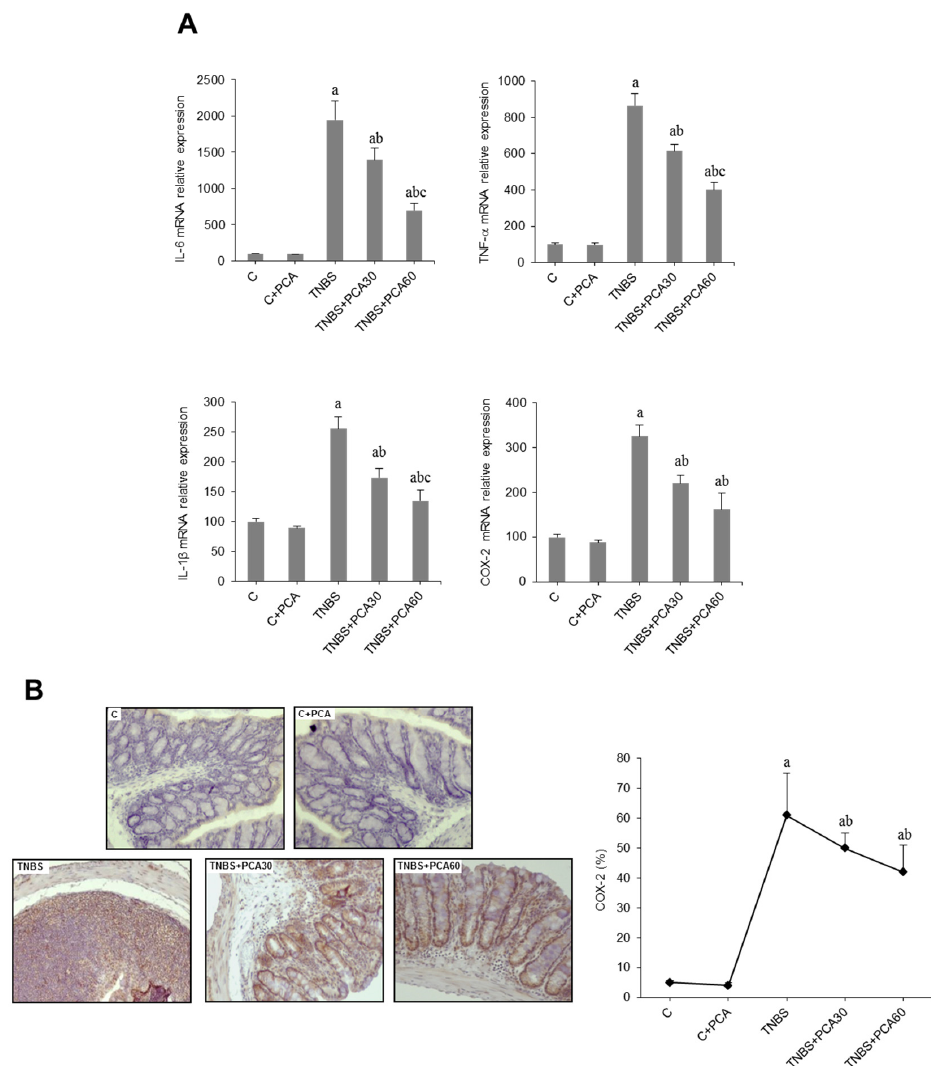
Figure 3. Effect of treatment with protocatechuic acid (PCA) on inflammation ‐ related genes in mice with 2,4,6 ‐ trinitrobenzenesulfonic acid (TNBS) ‐ induced colitis. mRNA expression of IL ‐ 6, TNF ‐α , IL ‐ 1 β and COX ‐ 2 genes ( A ). Representative sections of COX ‐ 2 immunohistochemistry in colonic tissues from C, C + PCA, TNBS, TNBS + PCA30 and TNBS + PCA60, and quantification of the positive cells. Image analysis was performed using the ImageJ software v3.91 with ten non ‐ overlapping randomly chosen histological fields. Photographs are taken under magnification ×200 ( B ). Data are expressed as the means ± SEM of six mice per group. a p < 0.05 vs. C group; b p < 0.05 vs. TNBS group; c p < 0.05 vs. TNBS + PCA30 group.